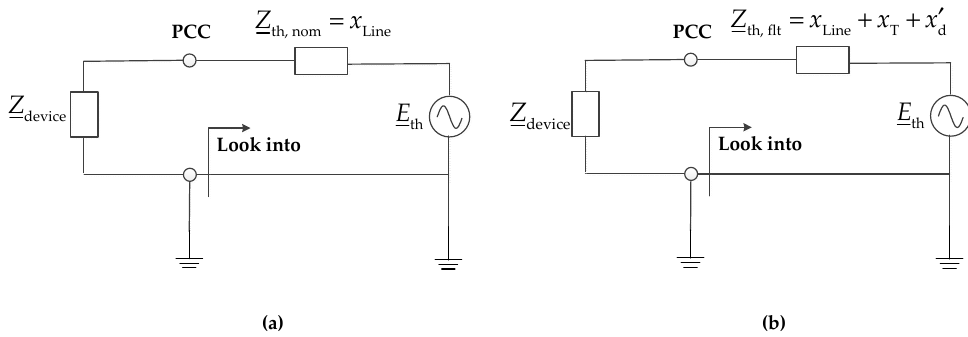
Figure 9. Thevenin equivalent circuit of the system when STATCOM adopts the constant AC voltage amplitude control and the constant active power control: ( a ) STATCOM is under the normal state; ( b ) STATCOM is under the fault state.